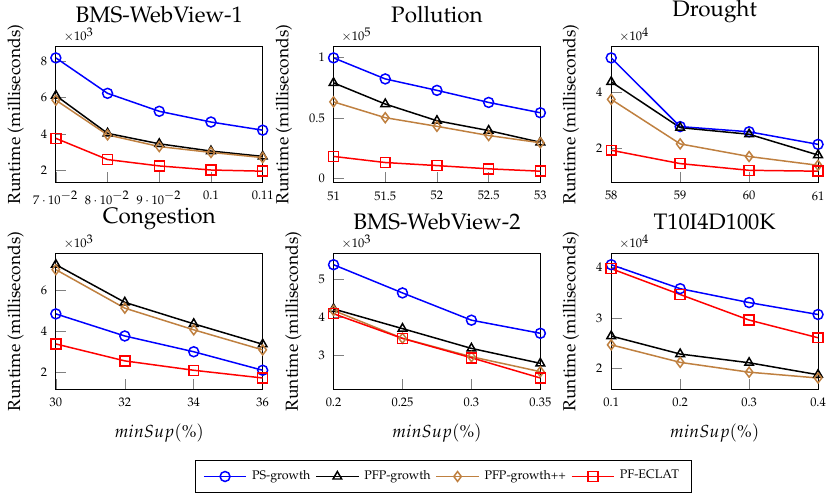
Figure 7. Runtime evaluation of algorithms at constant maxPer